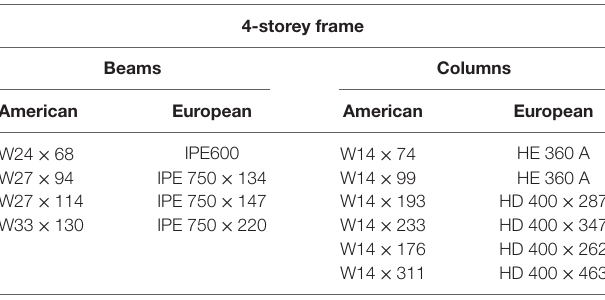
TaBle 2 | Selection of equivalent European sections for 4-storey frame.